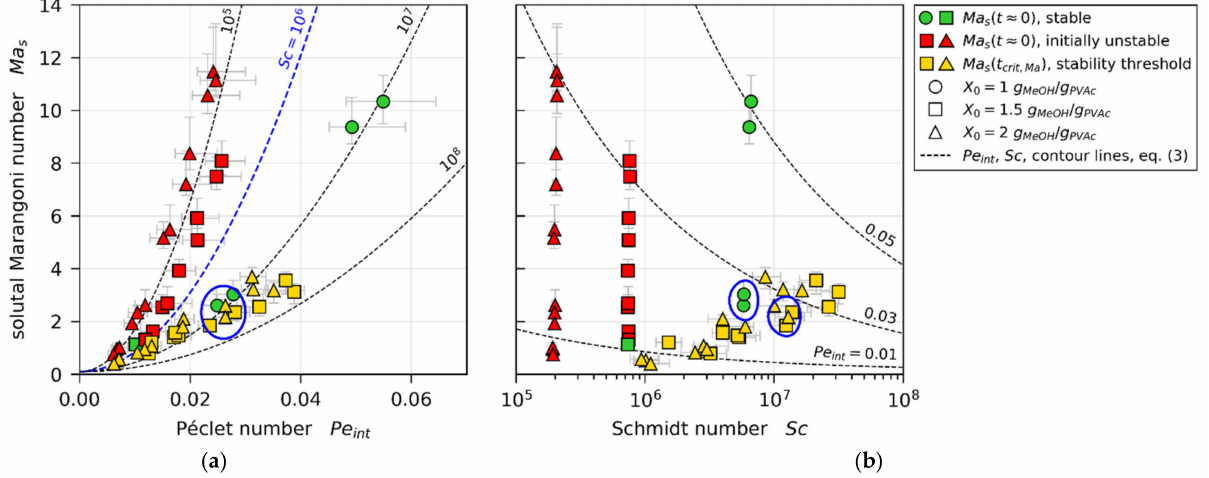
Figure 11. Solutal Marangoni numbers extracted from drying simulations matched to µ PTV experiments. ( a ) Plotted over P é clet number. ( b ) Plotted over Schmidt